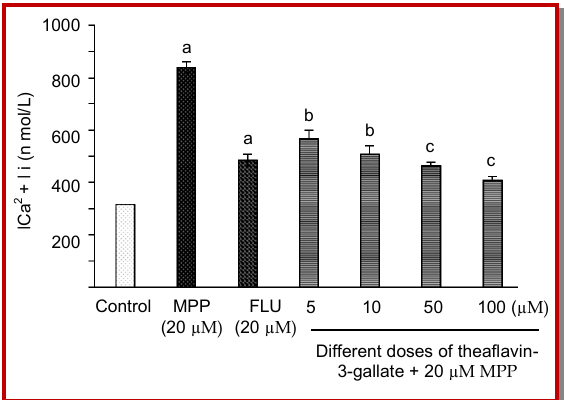
Figure 2: Effect of theaflavin-3-gallate on the concentration of Ca 2+ ion in 1-methyl-4-phenyl pyridinium-treated N2a cells. Values given are the mean ± S.E.M. (n = 6). a p<0.01 as com- pared with control group; b p<0.05, c p<0.01 as compared with